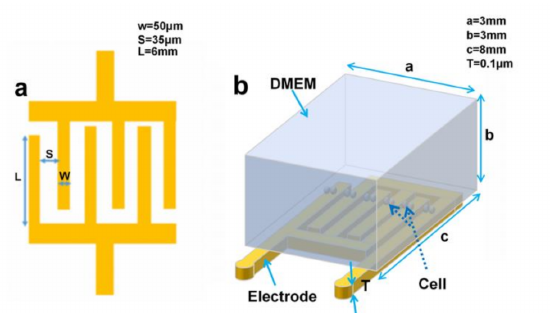
Figure 2. Schematic finite element method (FEM) model of interdigitated microelectrodes, Dul- becco’s modified Eagle medium (DMEM), and